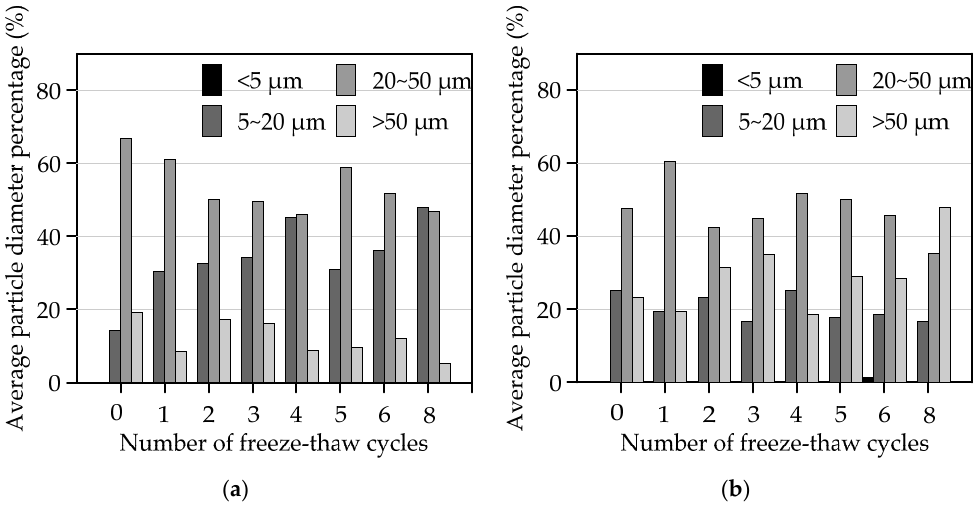
Figure 4. Average particle diameter percentage under F-T cycles: ( a ) S0 and ( b ) S2.